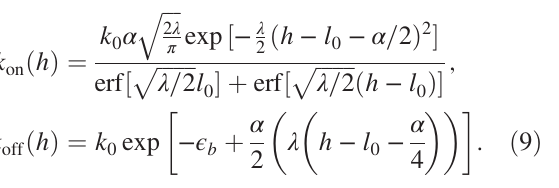
ffiffiffiffiffiffiffiffiffiffiffiffiffiffiffiffiffiffiffiffiffiffiffiffiffiffi p ð λα 2 = 2 π k